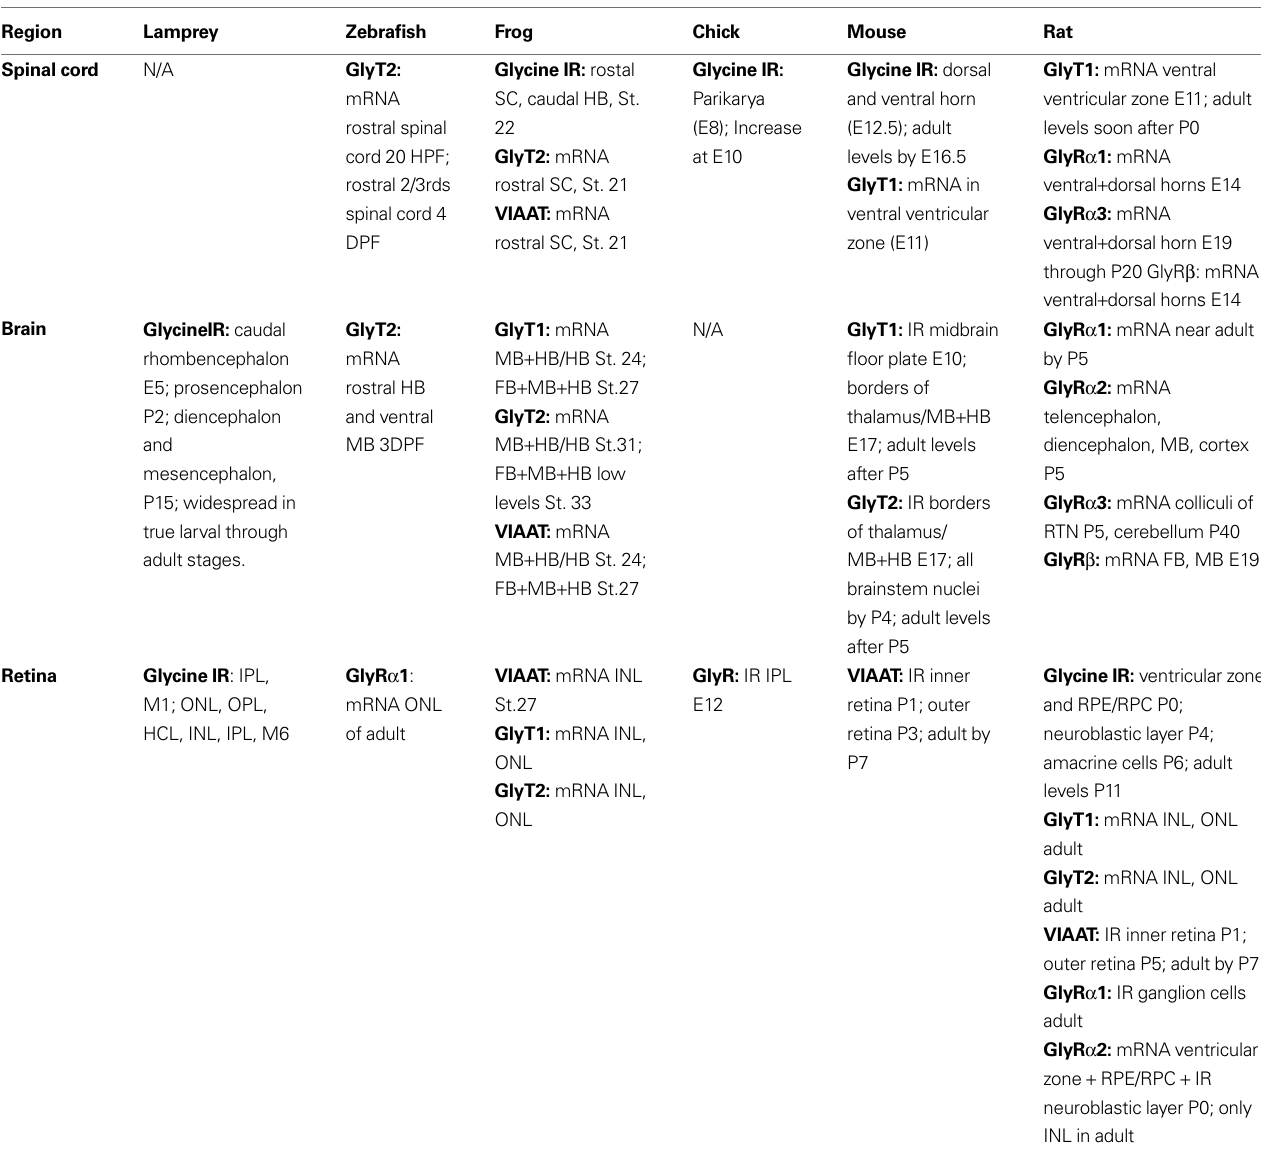
Table 1 | Summary of embryonic and early postnatal expression patterns for glycinergic markers. Region Lamprey Zebrafi